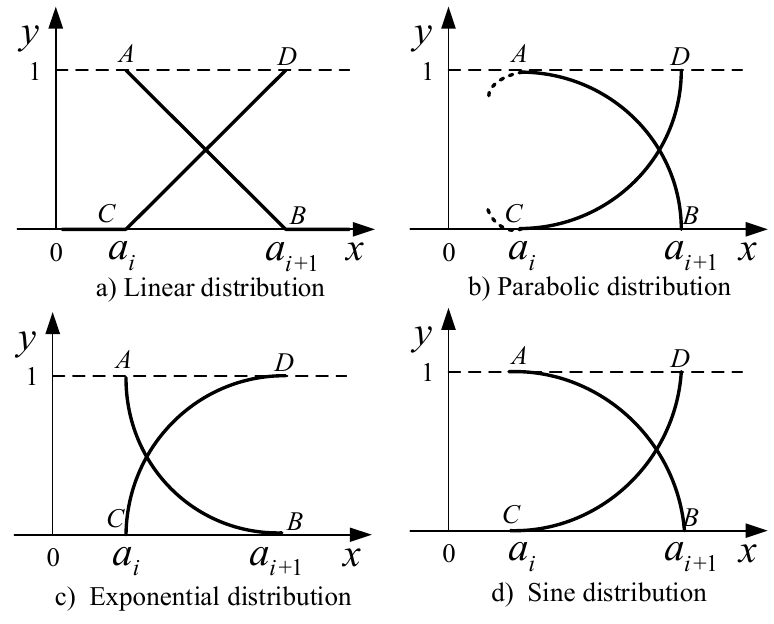
Figure 2. Grades of unascertained membership.